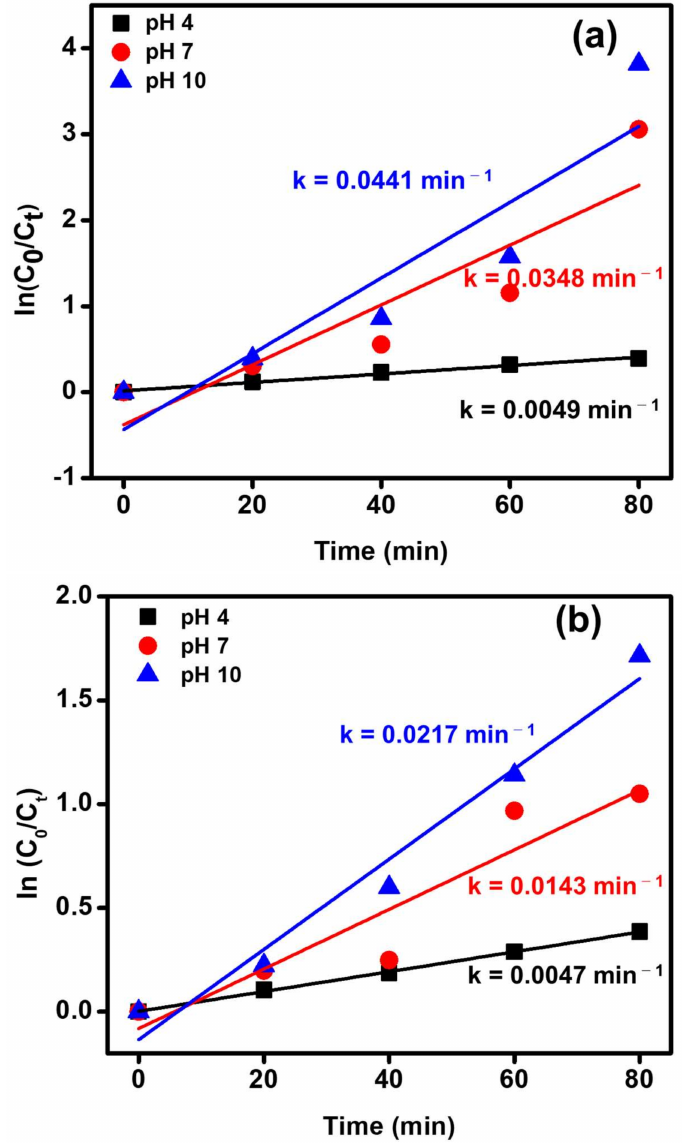
Figure 11. Pseudo-first-order kinetics for ( a ) MB and ( b ) MY photodegradation over the ZnO